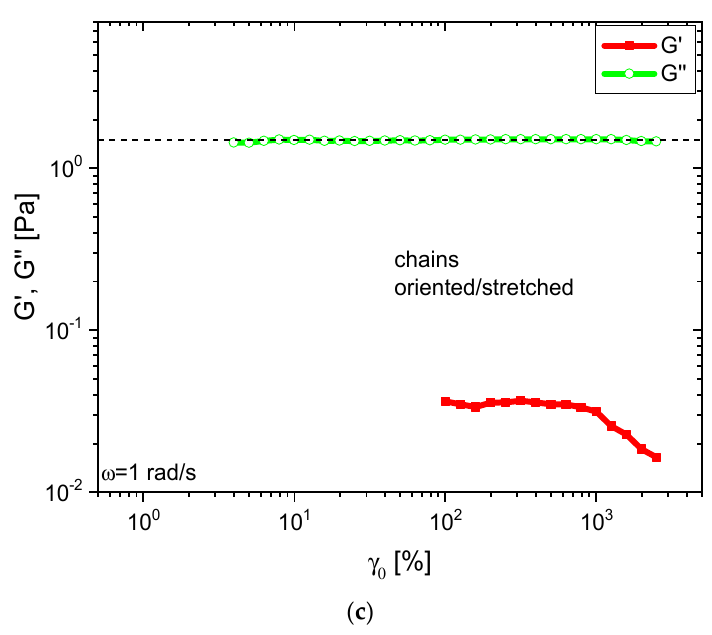
Figure 7. Strain sweep of ( a ) 12-w/v% Ni 2+ (from ref [7]) and 15-w/v% Ni 2+ samples; ( b ) 12-w/v% Fe 2+ and 15-w/v% Fe 2+ samples; and ( c ) the 12-w/v% Zn 2+ sample.